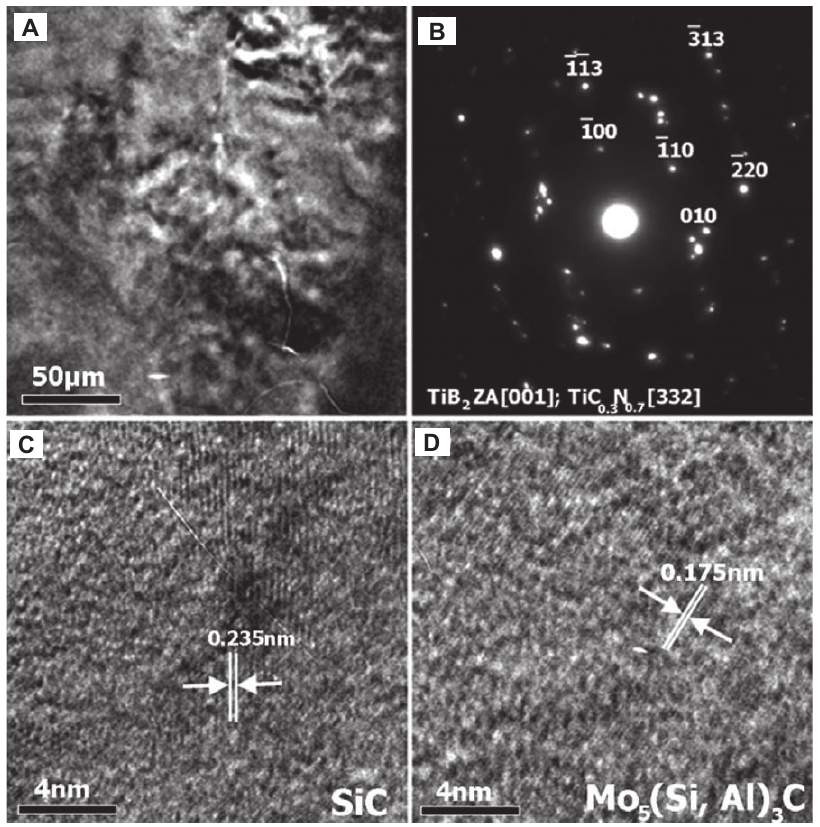
Figure 3 TEM micrographs (A), the diffraction pattern (B), the HREM morphologies of SiC (C), and Mo